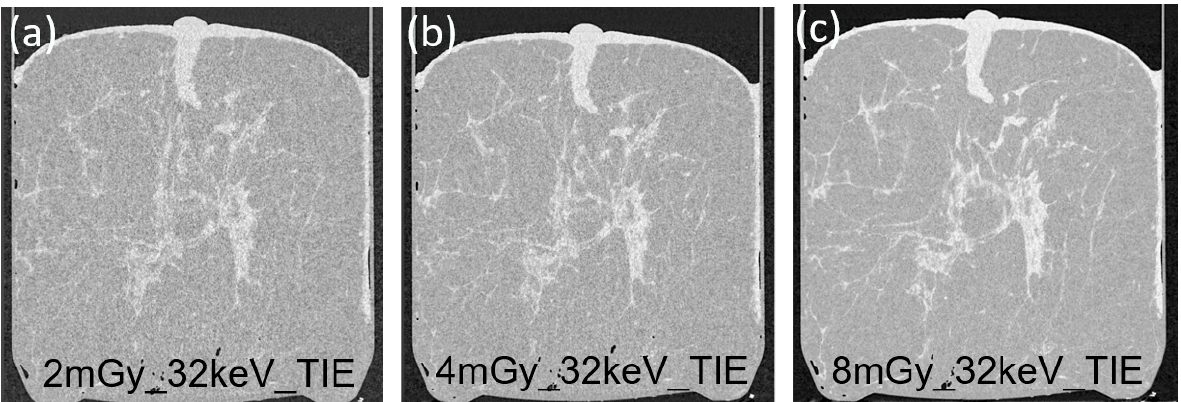
Figure 4. Comparison of PCT images of a breast tissue sample from a sagittal slice obtained with different MGD values: ( a ) 2, ( b ) 4, and ( c ) 8 mGy.